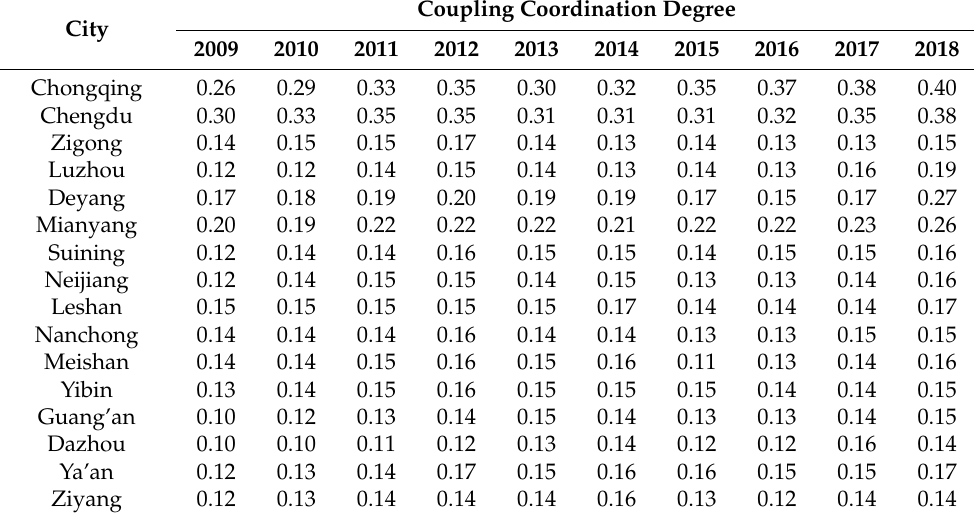
Table 2. The CCD results.